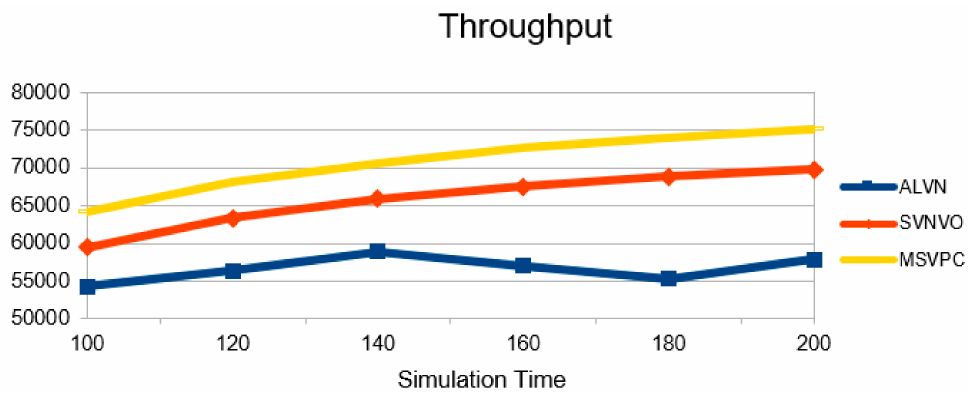
Figure 10. Simulation time vs.